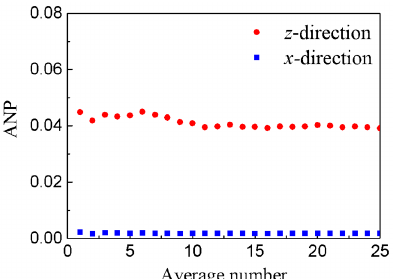
Figure 5. The a verage Acoustic Non-linearity ParameterANP versus the average number of simulations based on the displacement collected in the x -direction and z -direction using the models.